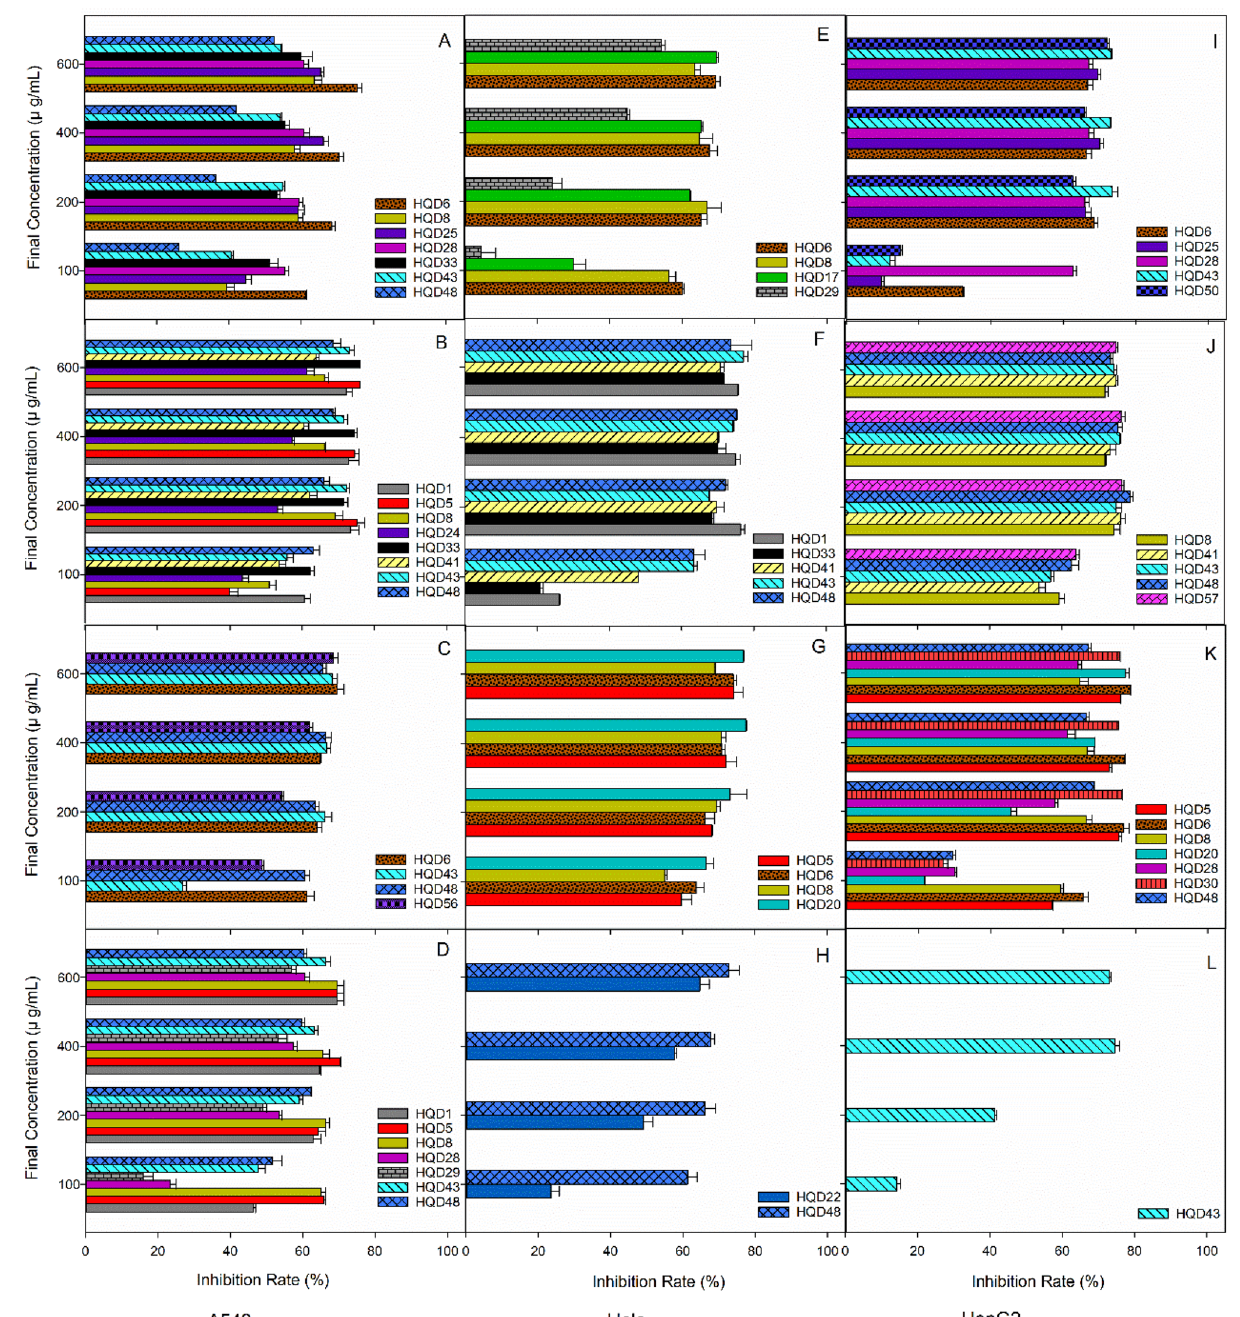
Figure 2. Antitumour activity of endophytic fungi from R. mucronata . ( A – D ) Shows that the fermentation products of endophytic fungi of R. mucronata have an inhibition rate for A549 tumor cells in different media, where ( A ) is obtained under dextrose agar (PDA) culture conditions, ( B ) is obtained under Czapek’s agar (CZA) culture conditions, ( C ) is obtained under rice medium (RM) culture conditions and ( D ) is obtained under grain medium (GM) culture conditions. ( E – H ) Shows that the fermentation products of endophytic fungi of R. mucronata have an inhibition rate for HeLa tumor cells in different media, where ( E ) is obtained under dextrose agar (PDA) culture conditions, ( F ) is obtained under Czapek’s agar (CZA) culture conditions, ( G ) is obtained under rice medium (RM) culture conditions and ( H ) is obtained under grain medium (GM) culture conditions. ( I – L ) Shows that the fermentation products of endophytic fungi of R. mucronata have an inhibition rate for HepG2 tumor cells in different media, where ( I ) is results under Dextrose Agar (PDA) cultural condition, ( J ) is results under Czapek’s Agar (CZA) cultural condition, ( K ) is results under Rice Medium (RM) cultural condition, and ( L ) is results under Grain Medium (GM) cultural